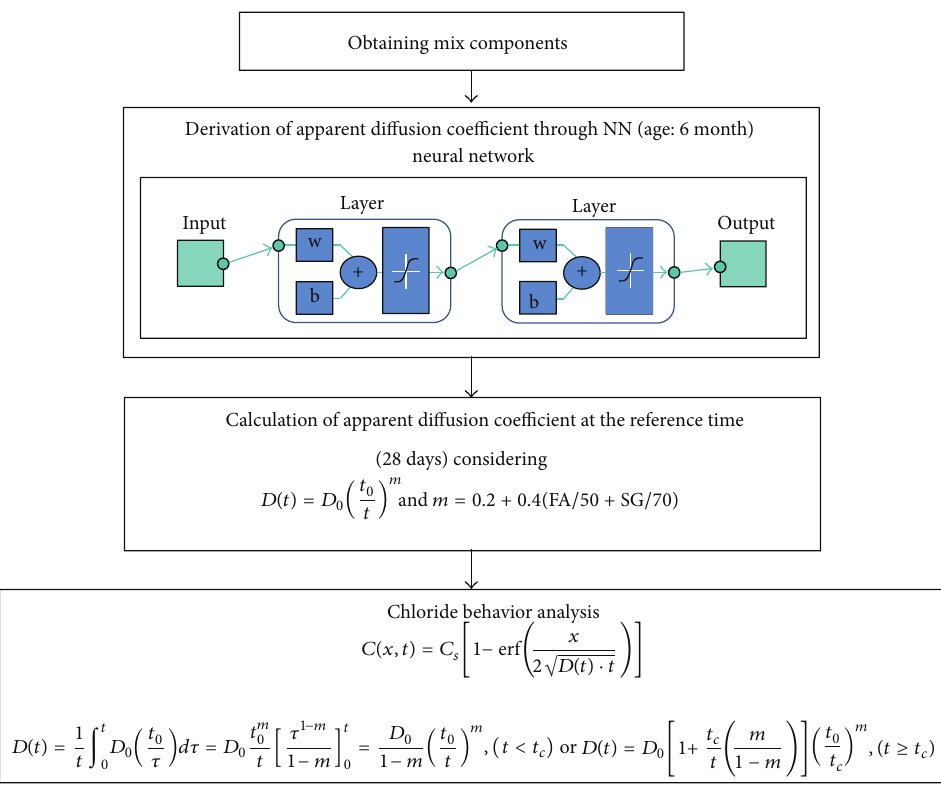
Figure 10: Prediction of chloride penetration using NNA and time-dependent diffusion.